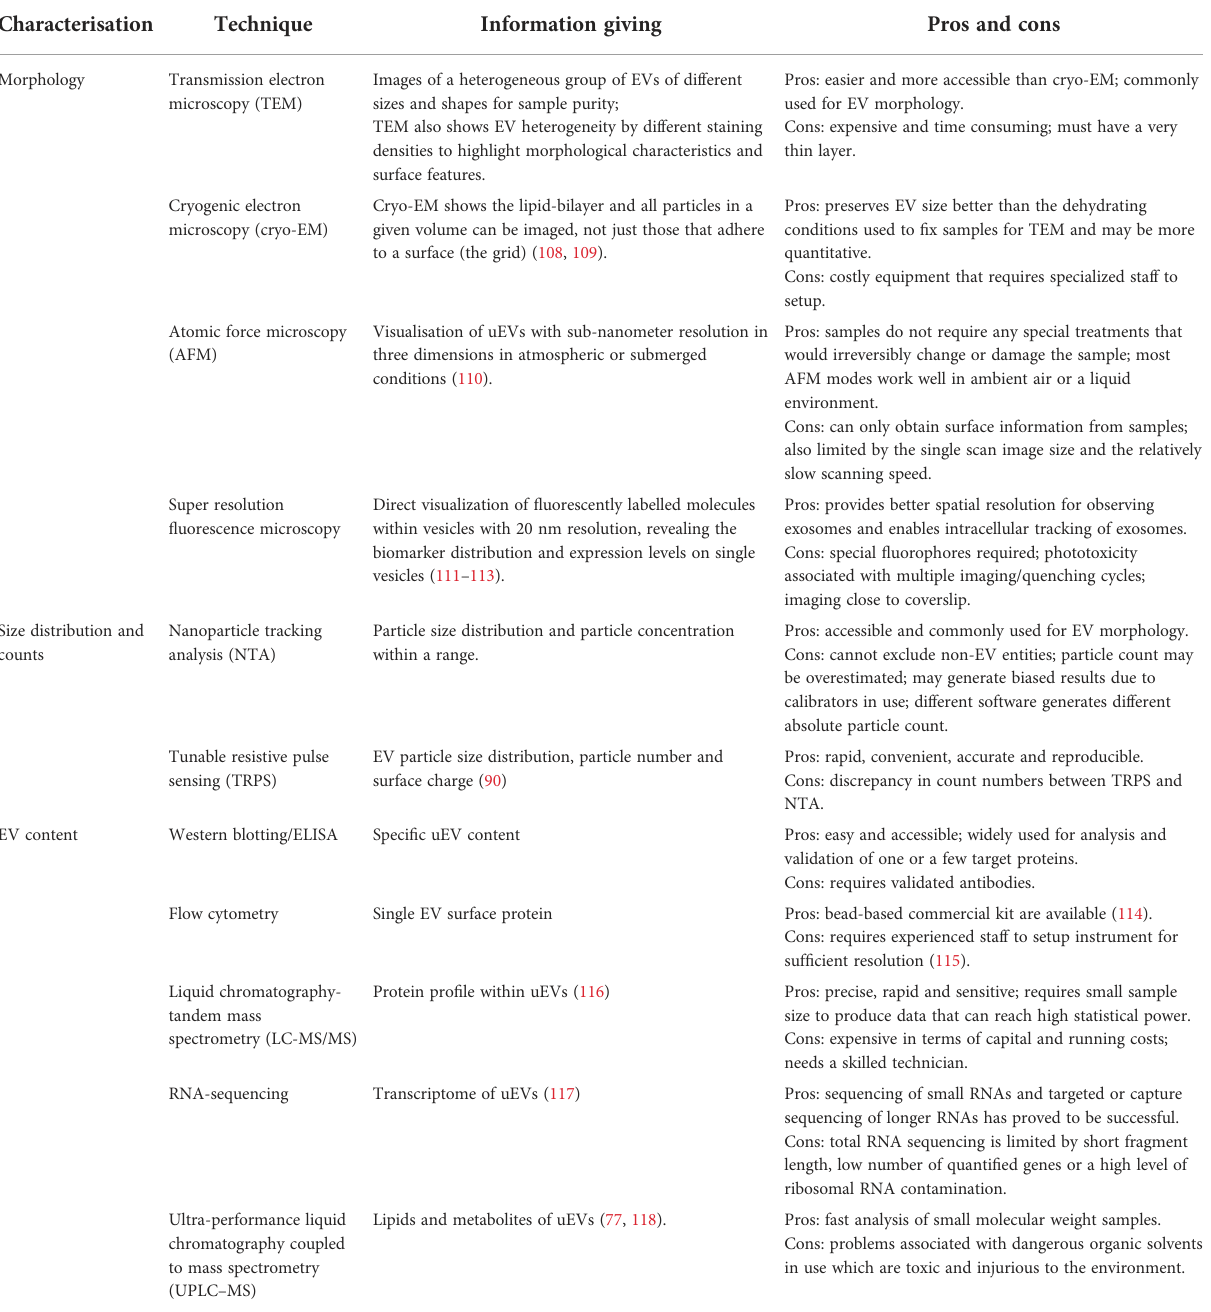
TABLE 4 Current techniques for uEV